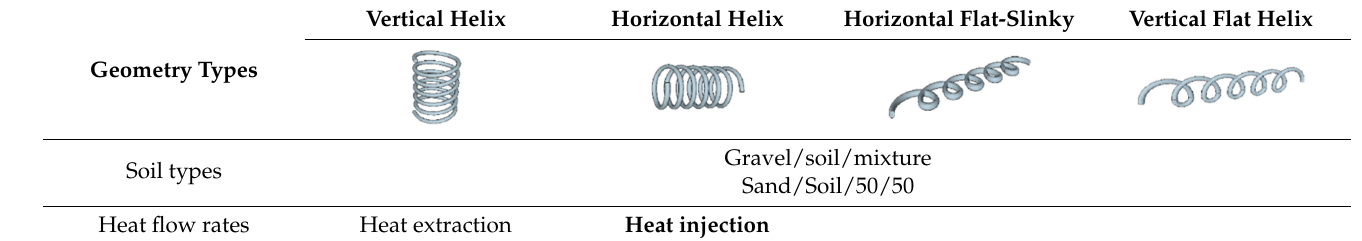
Table 3. Experimental overview.